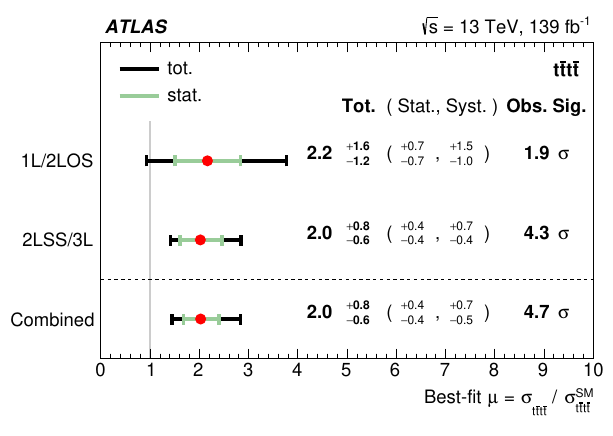
Figure 12 . Fitted signal strengths in the signal-plus-background fits to the same data set for the individual final states (1L/2LOS and 2LSS/3L) and the combined signal strength from all t ¯ tt ¯ t analysis